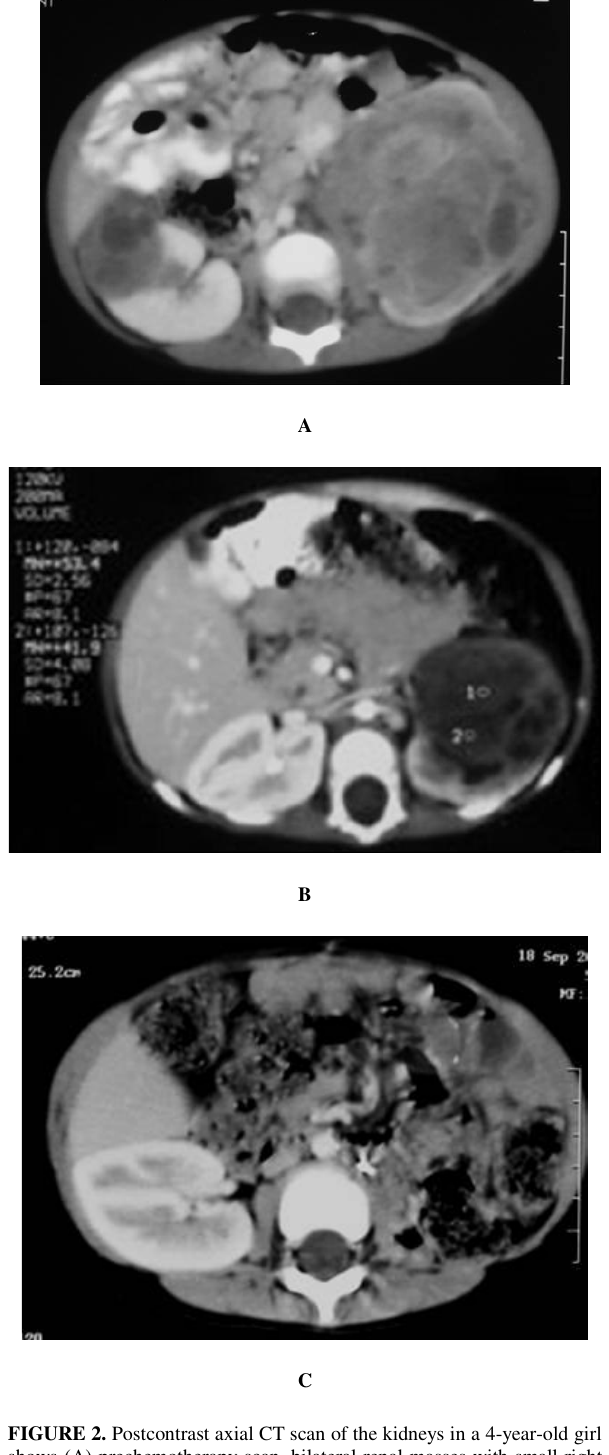
FIGURE 2. Postcontrast axial CT scan of the kidneys in a 4-year-old girl shows (A) prechemotherapy scan, bilateral renal masses with small right one and large mass at the left side extending into the perirenal space; (B) postchemotherapy scan, there is complete resolution of the right renal mass with significant reduction in the size of the left one; (C) post–left nephrectomy with free right kidney and no abnormalities at the left renal